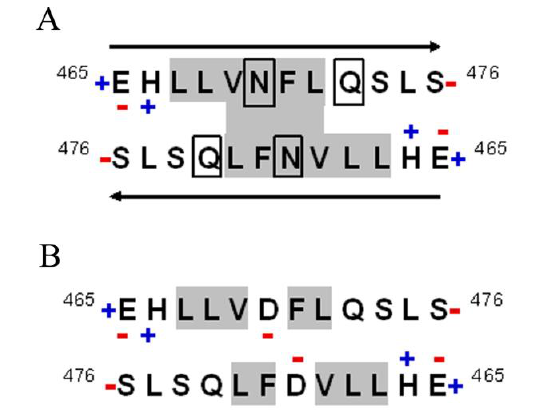
Figure 8. Model of an antiparallel β-strand in helix- Z . ( A ) The charge of each residue is determined considering a pH of 7.2. N and C terminal groups are loaded allowing an electrostatic attraction between peptide chains. Shaded regions identify the hydrophobic cluster L LVNFL , as well as N and Q residues; ( B ) Helix- X does not form a β-strand 467 472 structure due to the electrostatic repulsion between D